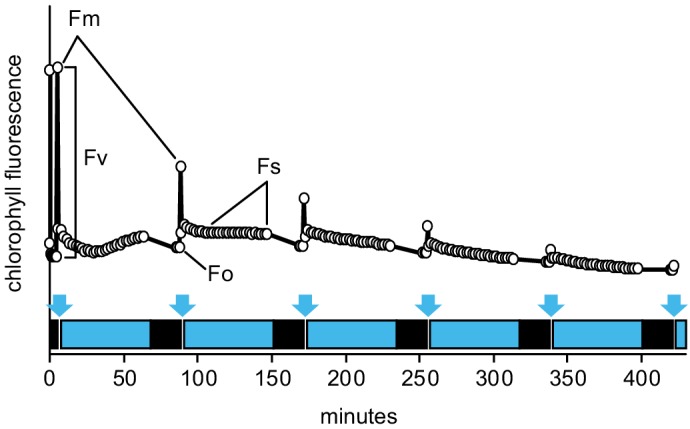
The Imaging PAM protocol developed to monitor kinetics of PSII inhibition by repetitive 1 hr light cycles.Plants dark-adapted for at least 20 min were first exposed to a saturating light pulse to measure Fm. Then the blue actinic light (450 nm, 80 µmol m−2 s−1) was turned on for 1 hr, over which time chlorophyll fluorescence under light (Fs) was followed by measuring flashes given once in 2 min. Then the actinic light was turned off to allow for 20 min dark adaptation, after which Fo and Fm were measured. Following the Fm measurement, the next light cycle was initiated. Saturating light pulses to measure Fm are depicted by blue arrows, actinic light periods by blue boxes, and dark adaptation by black boxes. PSII photochemical yield was calculated as Fv/Fm = (Fm-Fo)/Fm. To study different levels of MV tolerance, different concentrations of MV were employed throughout the study, as indicated in the figures or figure legends.